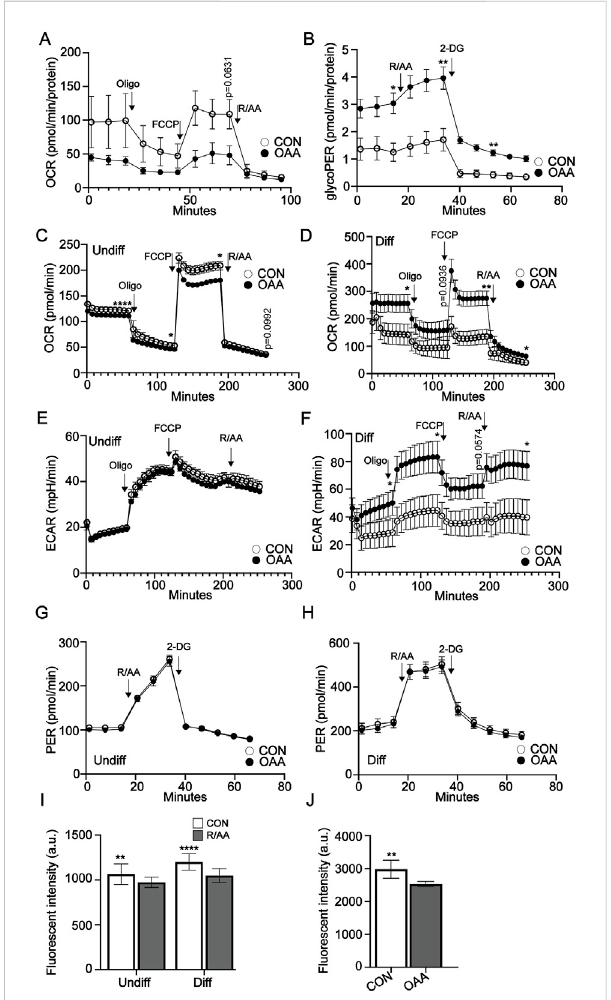
FIGURE 5 OAA-dependent modulation of cell metabolism and hypoxia. (A) Oxygen consumption rate (OCR) in P3 periosteal cells with and without OAA treatment. n = 4-5. (B) Glycolytic rate assay (GlycoPER) of P3 periosteal cells with and without OAA treatment. n = 4 – 6. Graphs represent average values ± SEM. OCR in (C) undifferentiated osteoprogenitors and (D) differentiated MC3T3 cells after treatment with OAA. Extracellular acidi fi cation rate (ECAR) in (E) undifferentiated osteoprogenitors and (F) differentiated MC3T3 cells after treatment with OAA. GlycoPER of (G) undifferentiated and (H) differentiated MC3T3 cells with or without OAA treatment. n = 9 – 24. Graphs represent average values ± SEM. (I) Quanti fi cation of intracellular hypoxia in osteoprogenitor and differentiated MC3T3 cells following inhibition of the electron transport chain using rotenone/antimycin A (R/AA). Graphs represent average values ± SD. n = 5 samples/ condition. (J) Quanti fi cation of intracellular hypoxia in osteoprogenitor MC3T3 cells after treatment with OAA. Graphs represent average values ± SD. n = 5 samples/condition. * p < 0.05, ** p < 0.01, **** p < 0.0001. p < 0.1 indicated on graph.